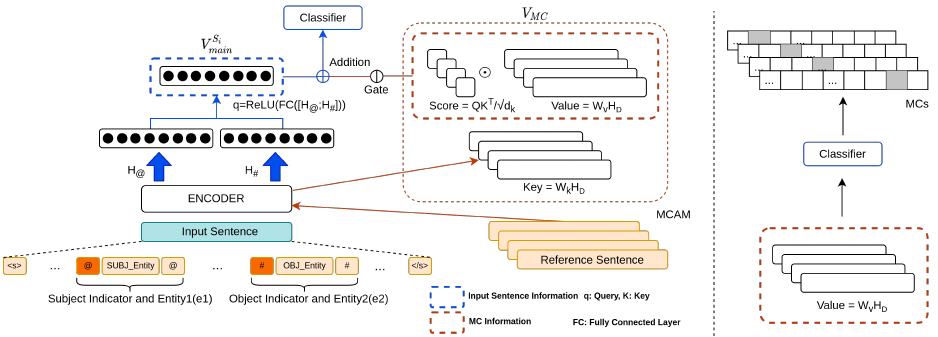
Figure 1. Overall architecture of our model: ( left ) aggregation of the main vector and the weighted sum of the value vectors and ( right ) incorporating MCs information into the value vector of corre- sponding MC. Following [31,32], special tokens (@, #) are used as entity indicators and added at before and after [Entity1] and [Entity2] tokens, respectively. We also trained a model to predict MC using its value vector alone and induced the model to align MC and its Ref vector. The representation D c 1 < s > , . . . , H D cn < s > ] vectors of Refs is denoted as H D = [ H